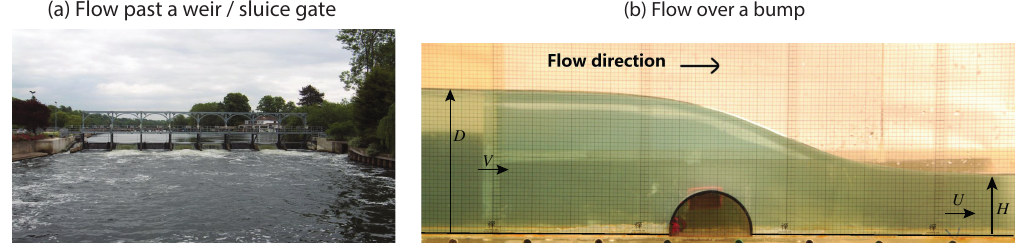
Figure 1. Open channel free-surface flow. ( a ) Sluice gates on the Thames near Henley (source: Wikipedia). ( b ) Hydraulic fall flow type V over a bump in a rectangular channel [19]. The flow is from left-to-right with uniform flow both far upstream and far